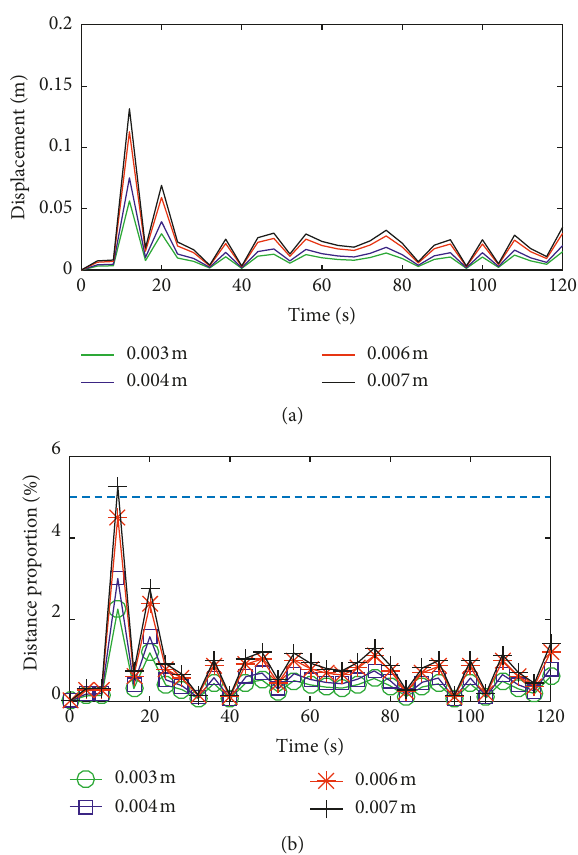
Figure 11: Lateral vibration of the catenary rope under different axial wobble amplitudes of the head sheave. (a) Total lateral vi- bration displacements. (b) Distance t /2 of the v ( )